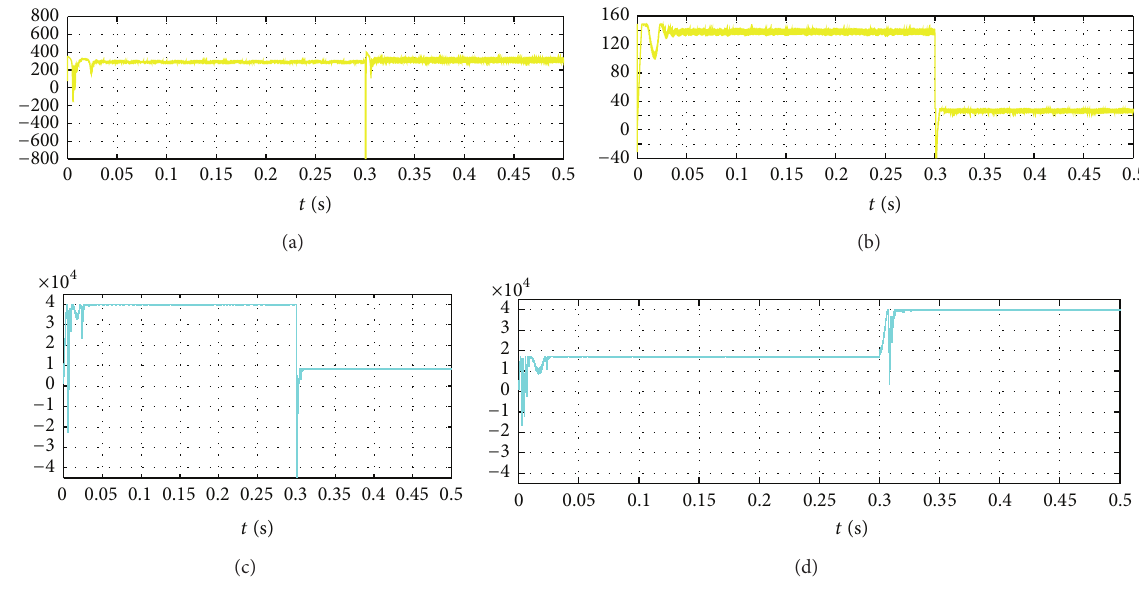
Figure 5: Maximum power point tracking simulation